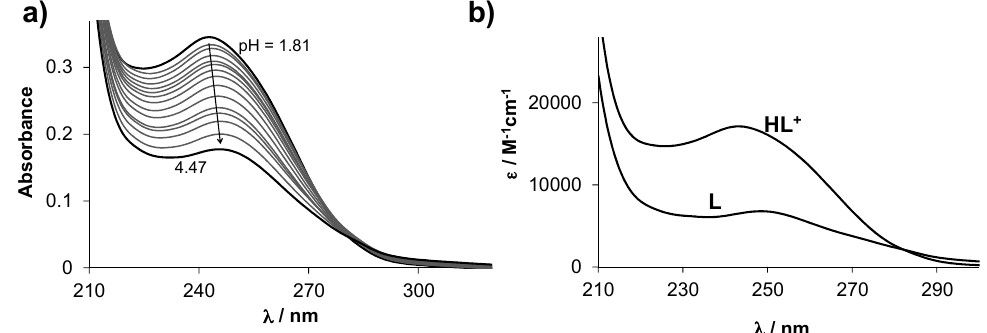
Figure 2. ( a ) UV spectra recorded for 6a at various pH values; ( b ) Calculated molar absorbance spectra for the HL + and L species of 6a . {c = 10 µ M; l = 2 cm; t = 25 ◦ C; I = 0.1 M (KCl); 1% ( v / v ) EtOH / H 2